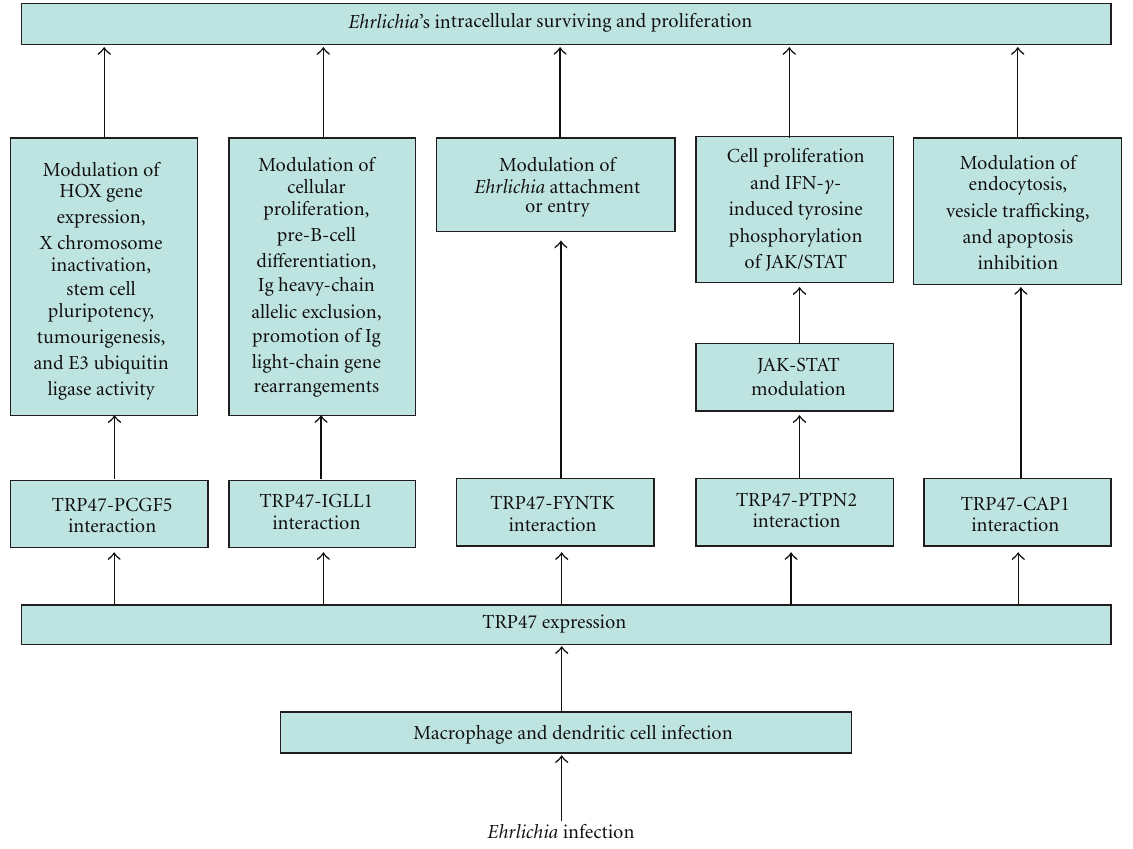
Figure 13: Ehrlichia e ff ectors and molecular host